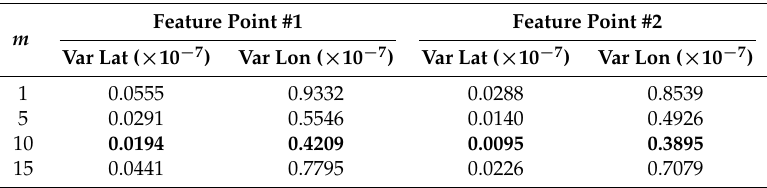
Figure 7. Distribution of mapped feature points (red) in Seq-1. (The arrow points to the direction of North.) The left column shows the case of Feature Point #1; the right column shows the case of Feature Point #2. The top row shows the features on images with their distances displayed in meters. The middle row shows the reconstructed points using one pair of frames. The bottom row shows the reconstructed points using five pairs of frames. Table 2. Reconstructed location (latitude and longitude) variances of two feature points in Seq-2 using different numbers ( m ) of frame pairs. The smallest variance value in each column is highlighted with bold